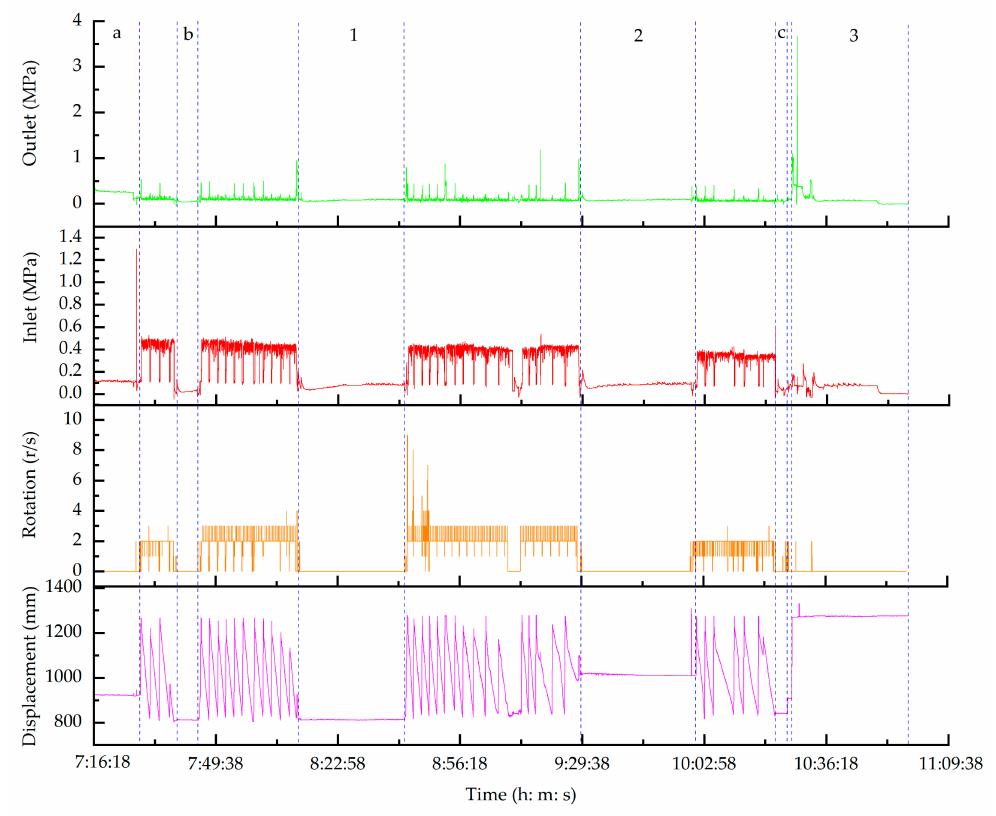
Figure 8. Rock-breaking response information–drilling time curves of a drilling rig drilling in Yan’an city on 11 September 2018 (drilling depth: 87.01–102.27